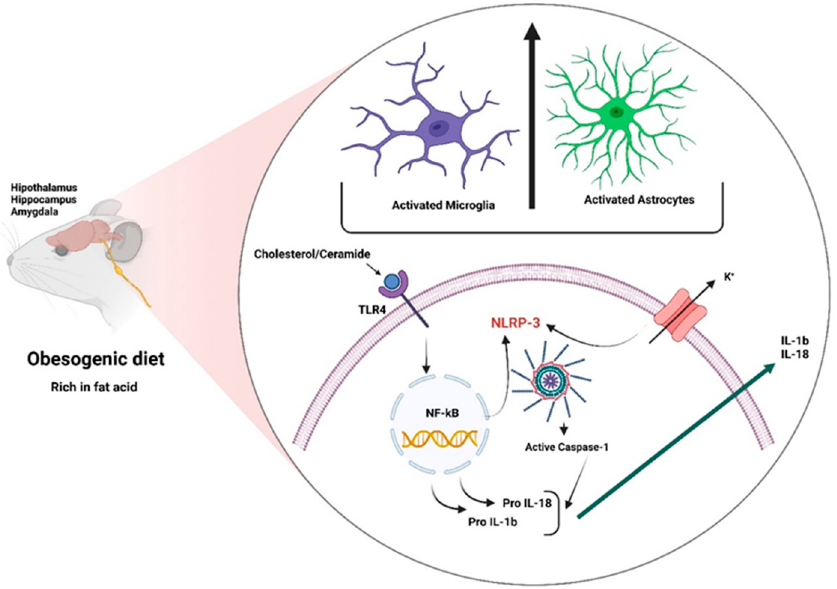
Figure 3. Activating the NLR family pyrin domain-containing 3 (NLRP3) inflammasome signaling pathway requires two signals. Signal 1 or priming is provided by pathogen-associated molecular patterns (PAMPs), danger-associated molecular patterns (DAMPs), cholesterol, or the activation of toll-like receptors (TLRs) or cytokine receptors, leading to the nuclear factor kappa-B NF- κ B activation that upregulates the levels of several inflammasome components such as the protein NLRP3, pro-IL-1 β , and pro-IL-18. Signal 2 or activation is provided by numerous PAMPs or DAMPs, including viruses, cholesterol, potassium efflux, reactive oxygen species (ROS), extracellular ATP, and lysosomal dysfunctions, among others. ASC, an adaptor protein, recruits NLRP3 and pro-caspase-1 to form the NLRP3 inflammasome complex. Caspase-1 promotes the processing of interleukins for their subsequent release. This figure was created with BioRender.com under a subscription and has a license from BioRender to use the figure in journal